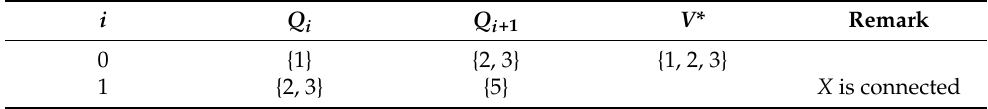
Table 3. Process from the proposed PLSA for Figure